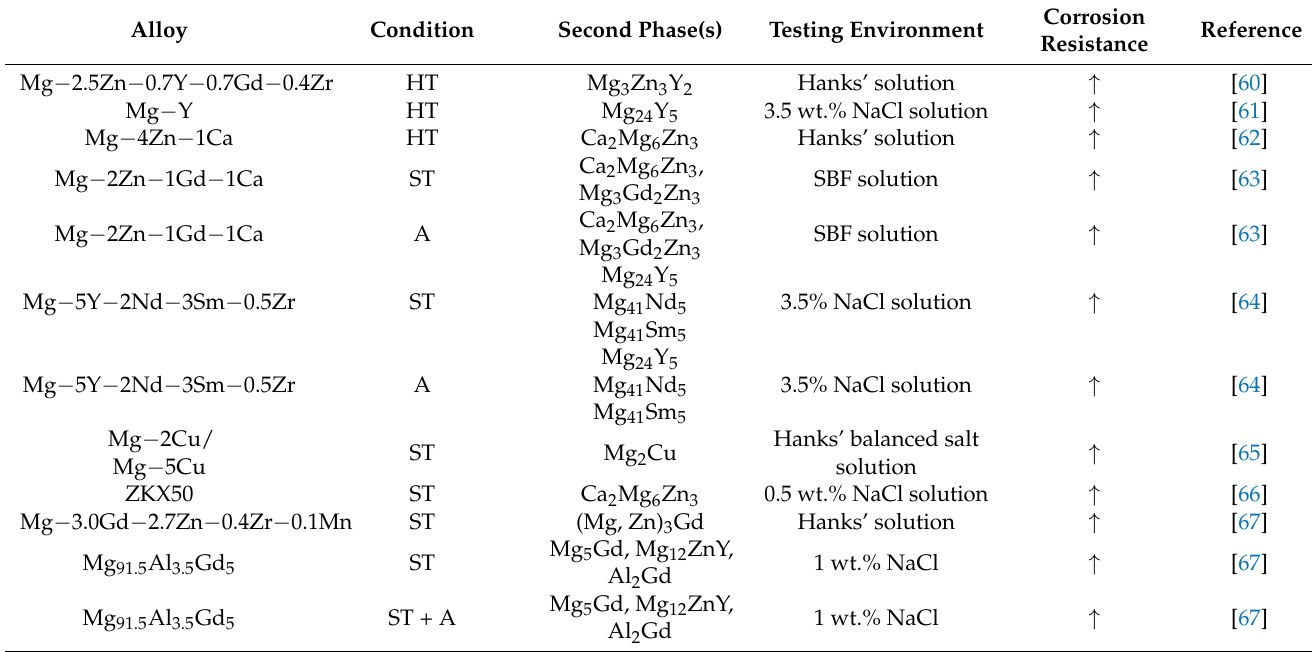
Table 1. Changes in corrosion resistance of common magnesium alloys after different heat treatments (HT: Homogenization − treatment; ST: Solution − treatment, A: Aged −